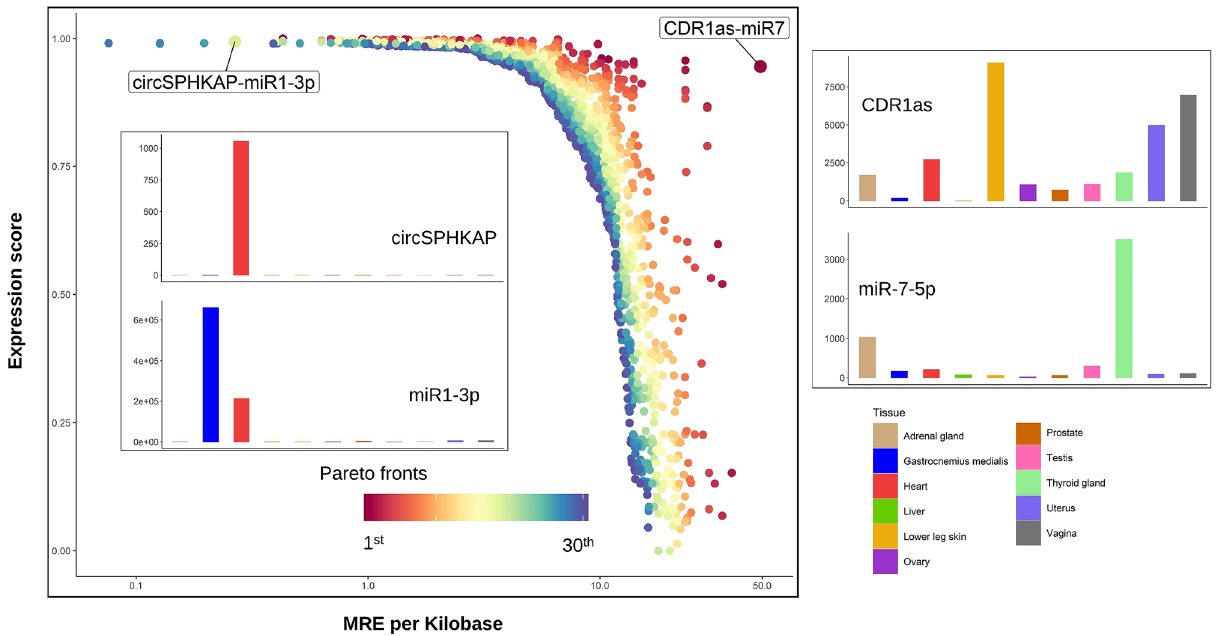
Figure 2. Pareto Frontier Analysis re-prioritize ceRNA interactions by integrating gene expression with MRE data. 2531 circRNA-miRNA interactions on the top 30 Pareto fronts. Tissue-specific expression for selected ceRNA interactions: CDR1as and miR-7, and CircSPHKAP and miR-1. R package ggplot2 v3.3.2 (https ://cran.r- proje ct.org/web/packa ges/ggplo t2/index .html) was used to create the figure.